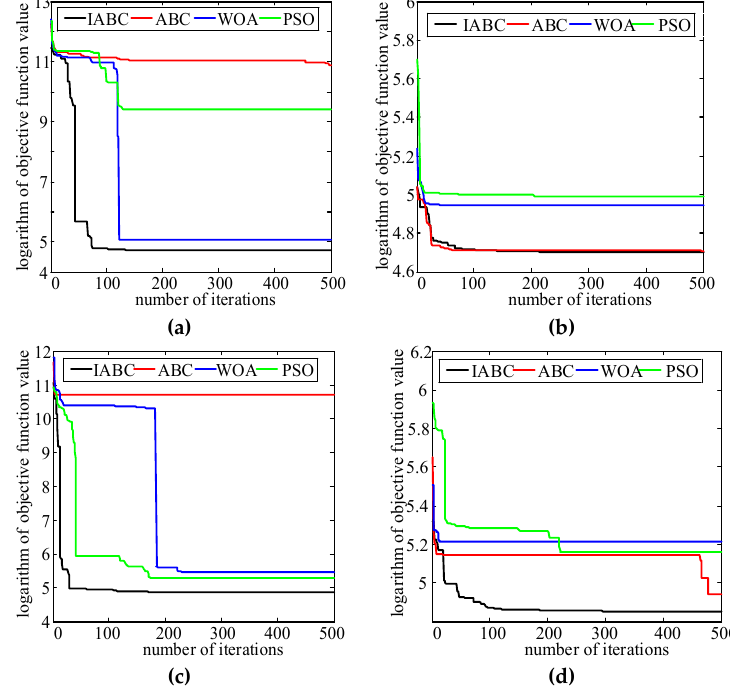
Figure 10. Convergence curves vs. various algorithms: ( a ) Convergence curves under FEL; ( b ) Convergence curves under FHL; ( c ) Convergence curves under IFEL; ( d ) Convergence curves under IFHL.